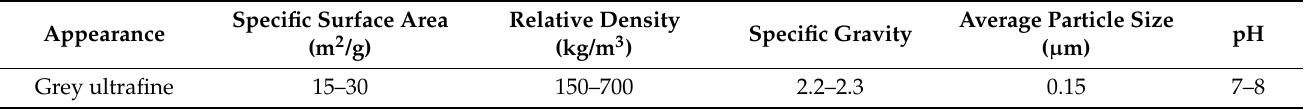
Table 2. Technical characteristics of silica